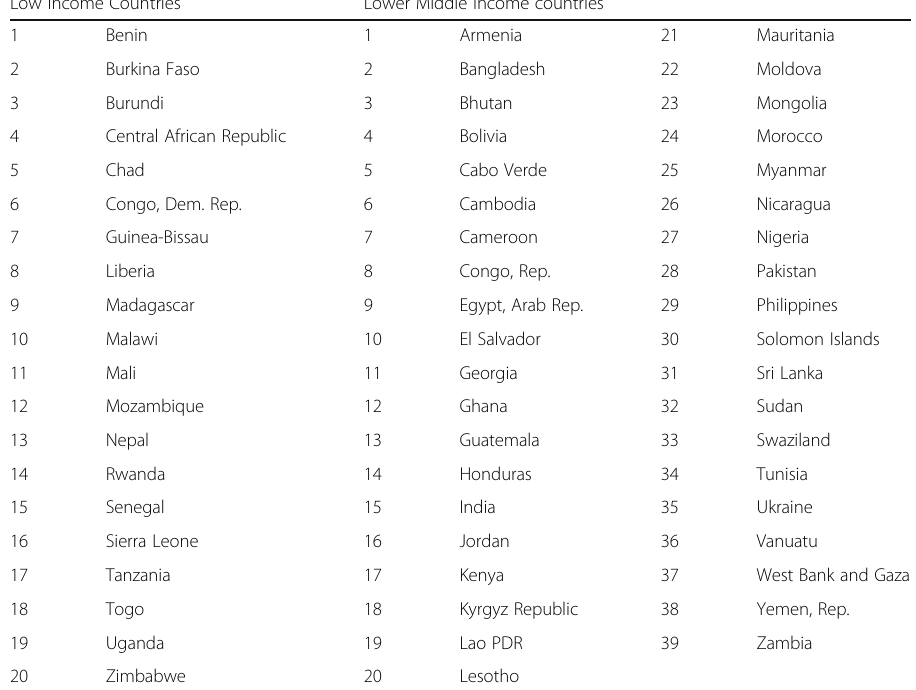
Table 8 List of developing countries Low Income Countries